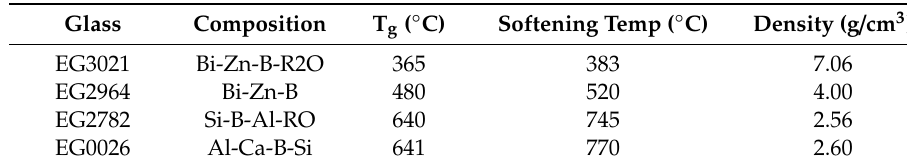
Table 1. Properties of di ff erent Ferro glasses.